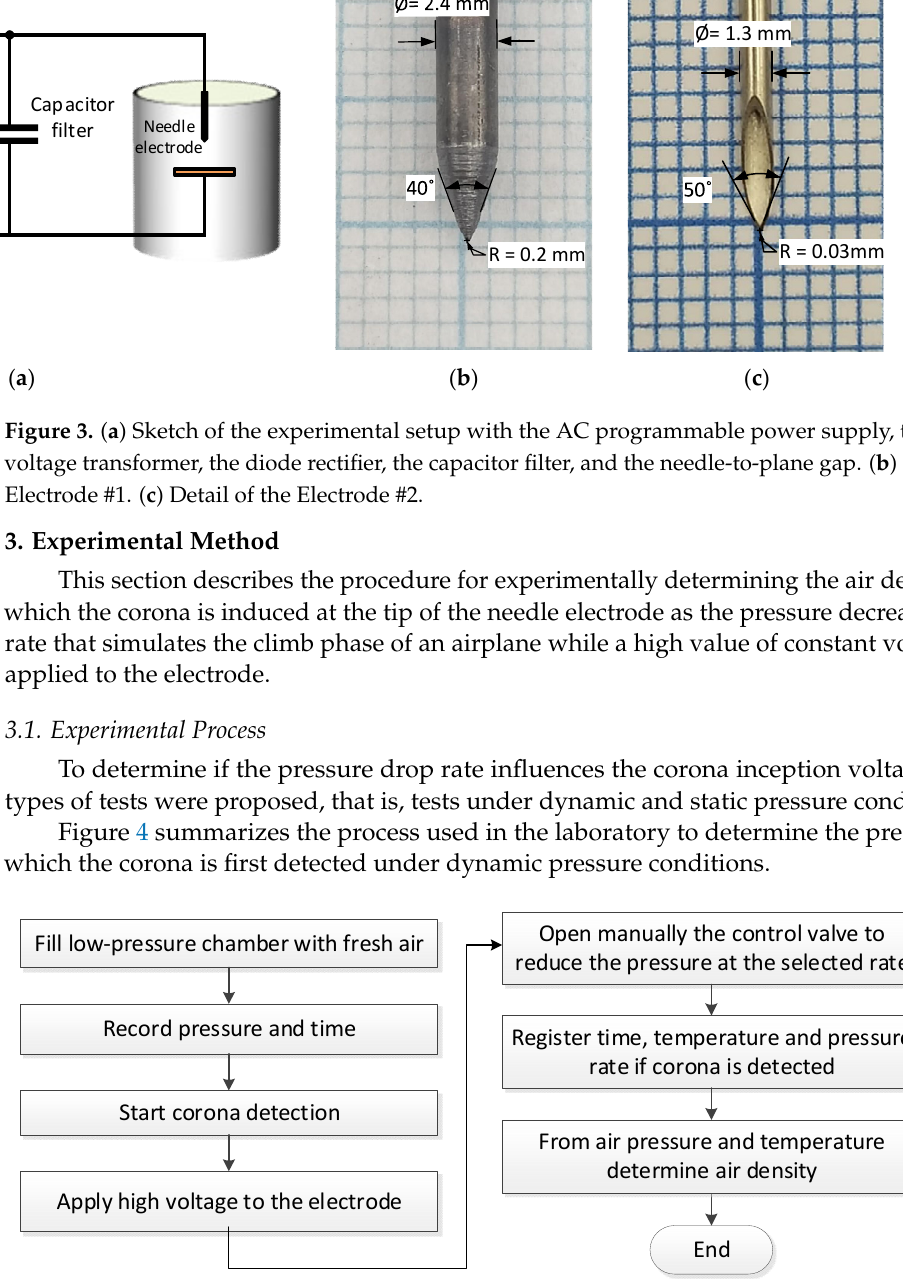
Figure 4. Flowchart of the laboratory procedure used to determine the pressure at which corona is first detected under dynamic pressure conditions.